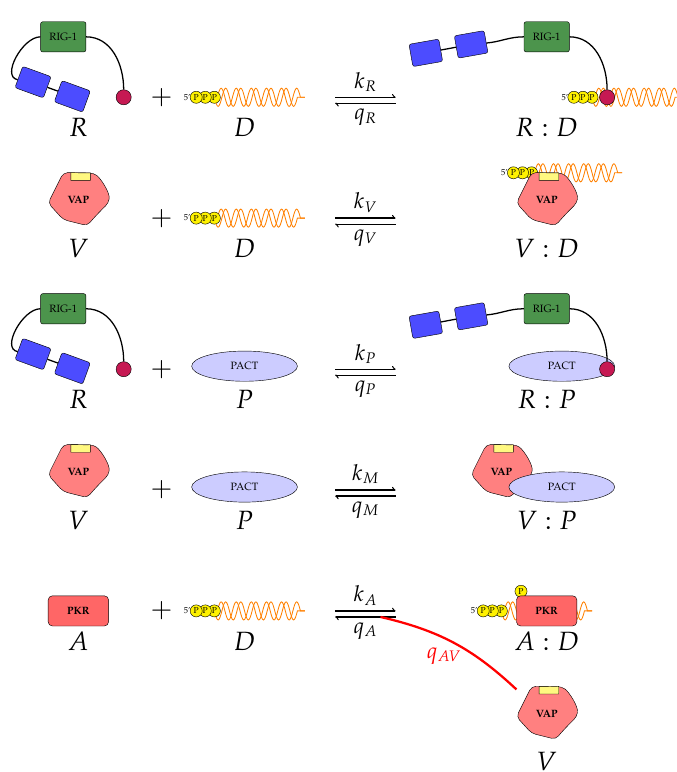
Figure 3. A third model of type I IFN inhibition by viral protein (model 3). It includes the contribution of the PKR pathway. In this model there are ten reactions and five molecular complexes. In the presence of free VAP, phosphorylated PKR is actively de-phosphorylated, as indicated by the red reverse reaction arrow with rate q AV